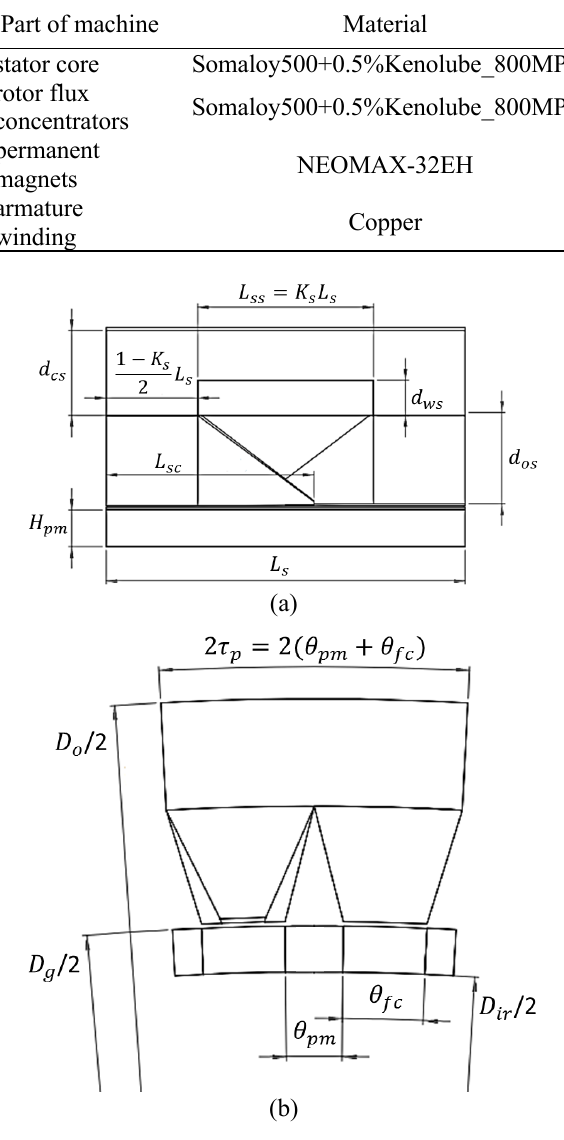
Figure 4: Main sizing parameters of the claw pole TFPM motor (a) Side view (b) Front view.